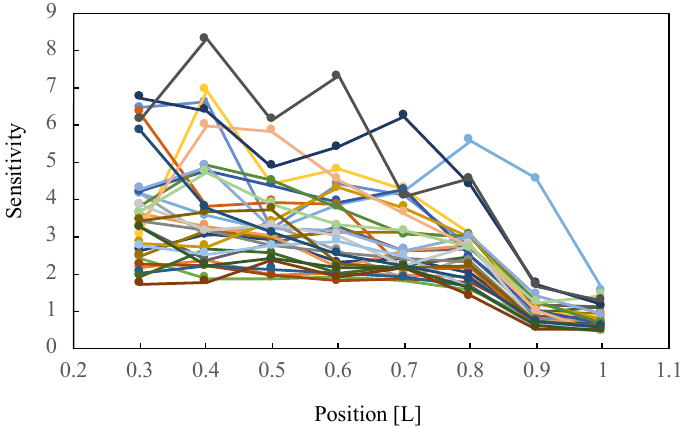
Figure 7. Sensitivity distribution.